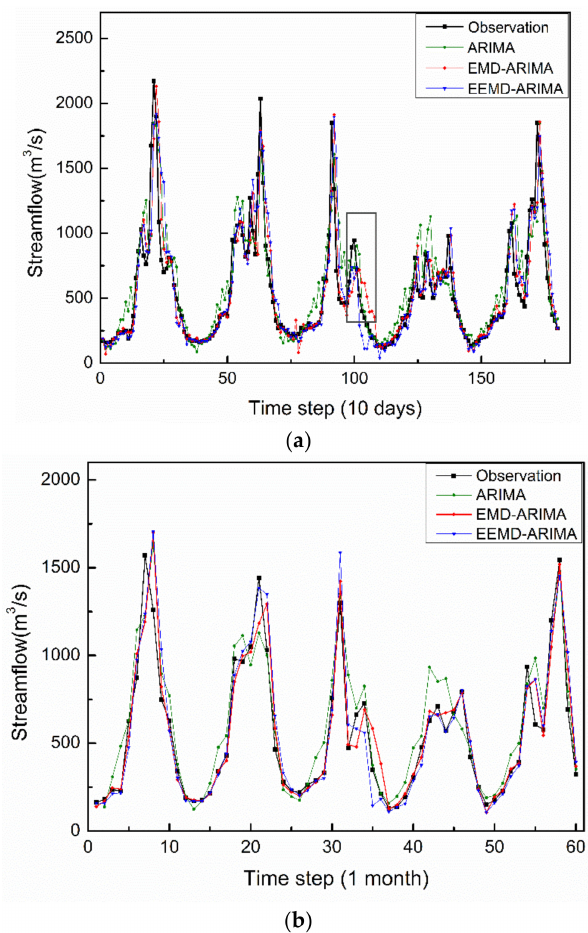
Figure 4. Streamflow prediction by proposed hybrid methods from the year 2013 to 2017 ( a ) with a time step of ( a ) ten days; ( b ) one month.